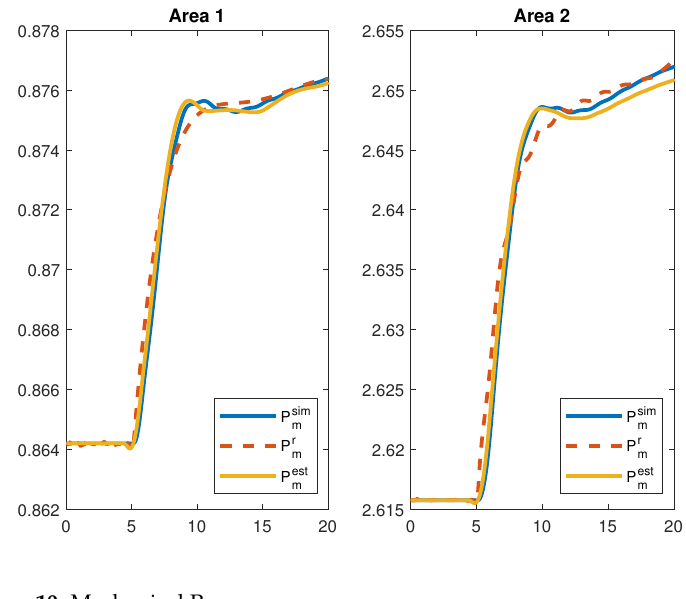
Figure 10. Mechanical